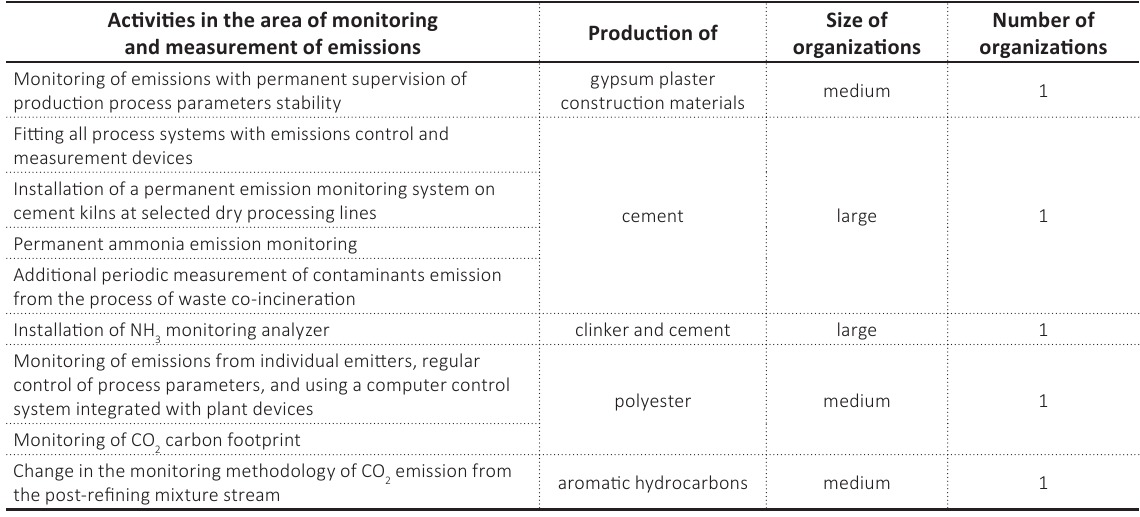
Table 4. Activities in the area of monitoring and measurement of emissions undertaken by Polish companies registered with